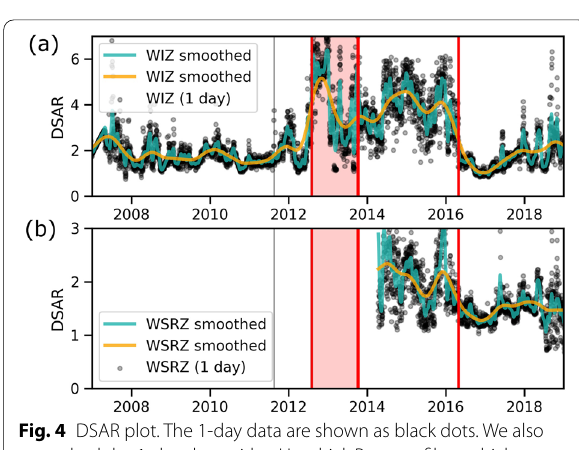
Fig. 4 DSAR plot. The 1-day data are shown as black dots. We also smoothed the 1-day data with a Hendrick Prescott filter, which prevents temporal aliasing (blue line (parameter 1000) and orange = (parameter 10 8 ) lines). Note that the y -scales are different. See Fig. 4 = for the description of the vertical lines corresponding to key time periods. Each tick on the x -axis corresponds to 1 January of each